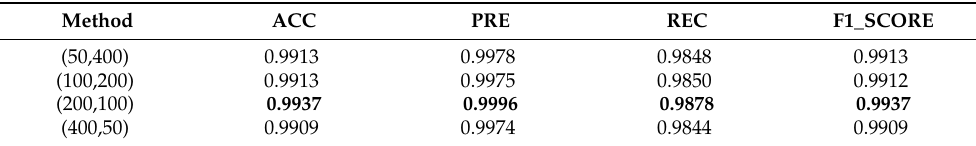
Table 6. The first number in the method field represents the number of solutions in the population and the second number represents the number of iteration rounds.